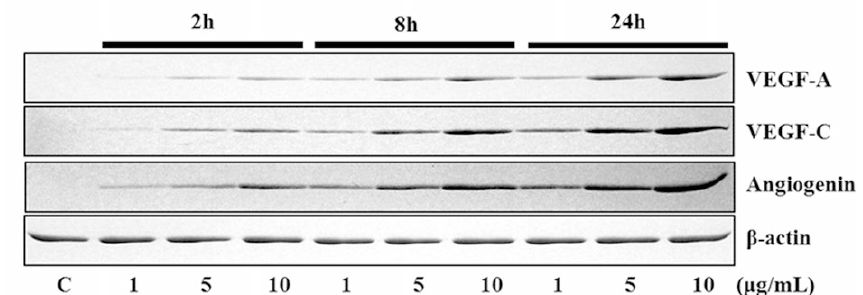
Figure 2. Increase in the vascular endothelial growth factor (VEGF)-A and C, and angiogenin expression after treatment of 4-HR. Reproduced with permission from Kim, S. G. [34].